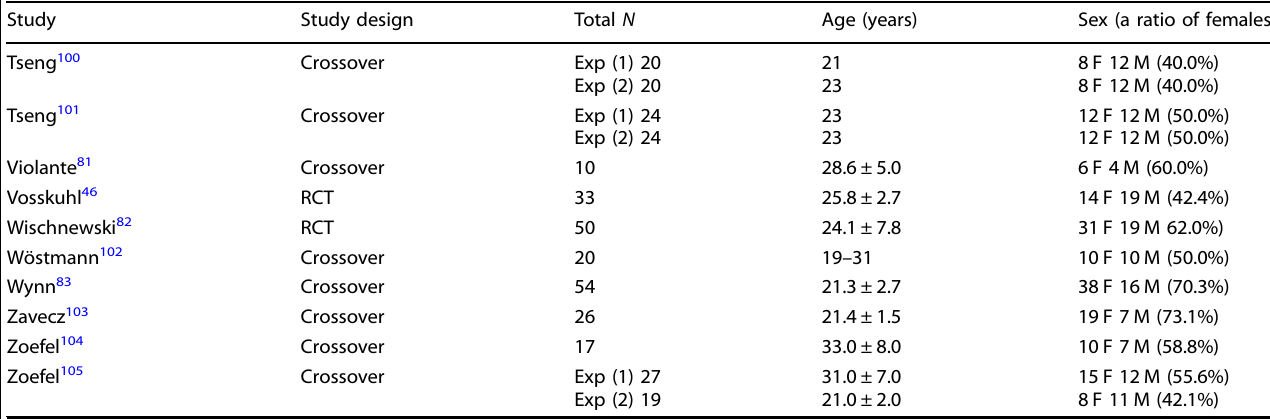
AP published in the Acta Psychologica, BP published in the Biological Psychology, Exp experiment, F female, M male, NR not reported, RCT randomized controlled trial. Data for age is mean± standard